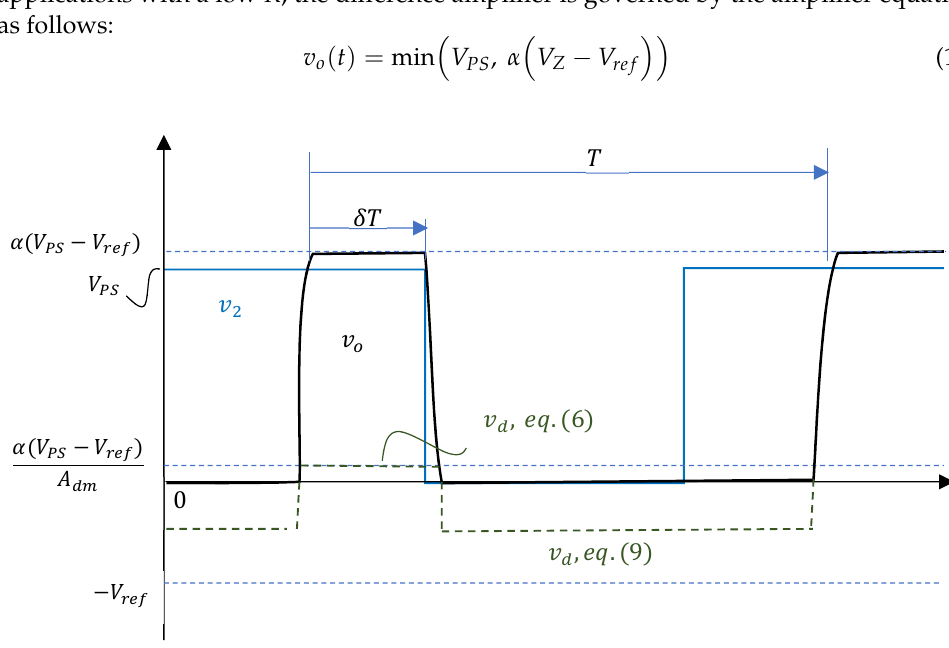
Figure 8. Response of a dCCDA with large resistance.